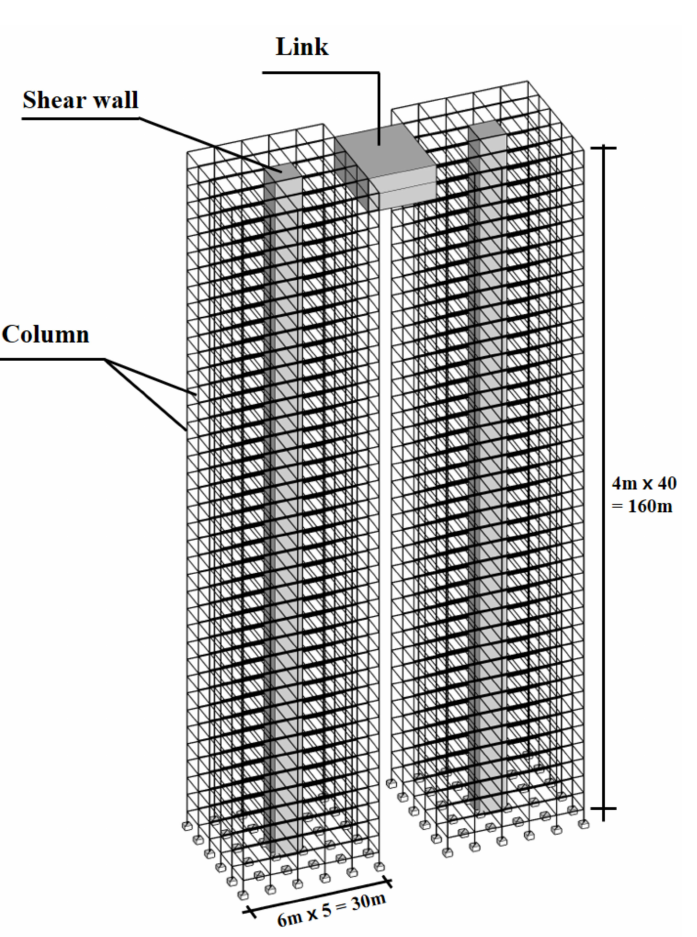
Figure 12. Structural system of